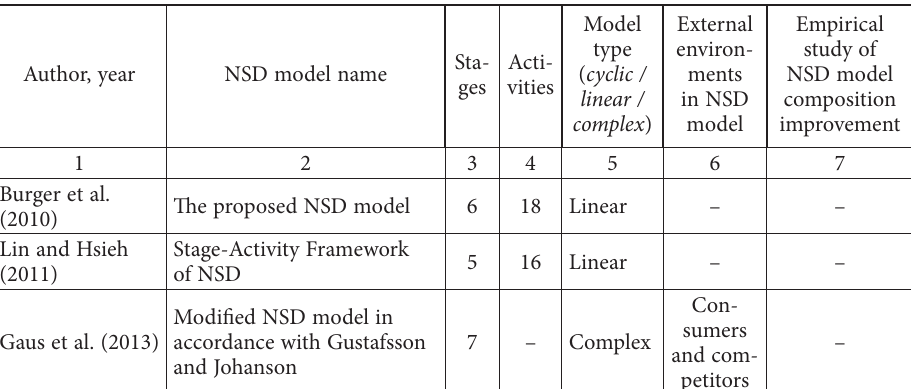
Table 1. Comparison of the latest NSD models (source: compiled by the authors)